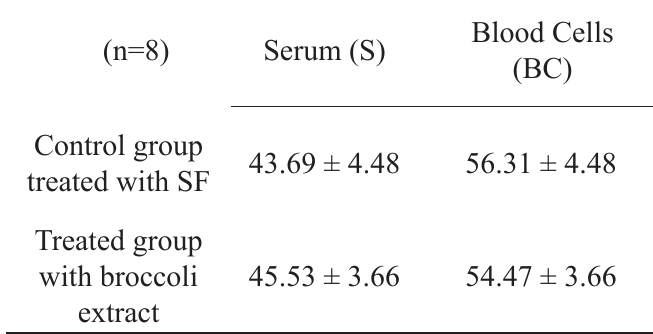
TABLE 3 - The percentage of radioactivity for P and